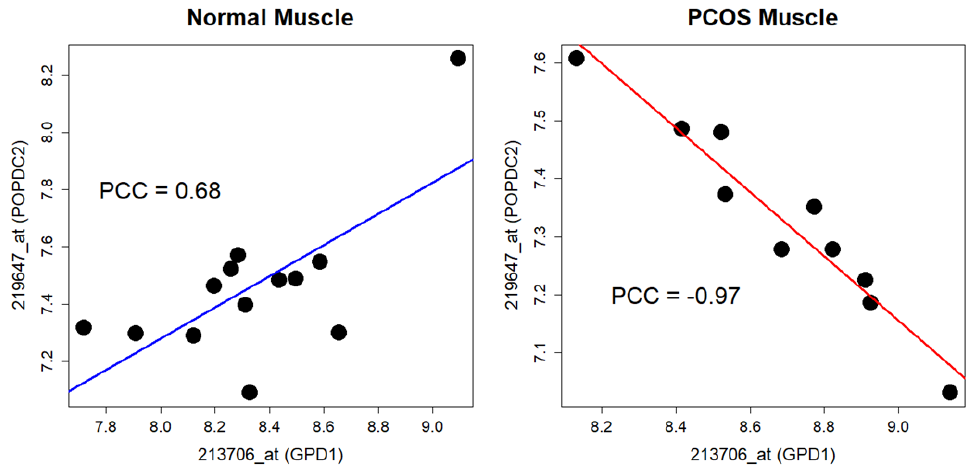
Figure 4. Differential coexpression of GPD1 and POPDC2 in GSE8157. Note that signs of the correlations between the genes are opposite. PCOS—polycystic ovarian syndrome; PCC—Pearson’s correlation coefficient.